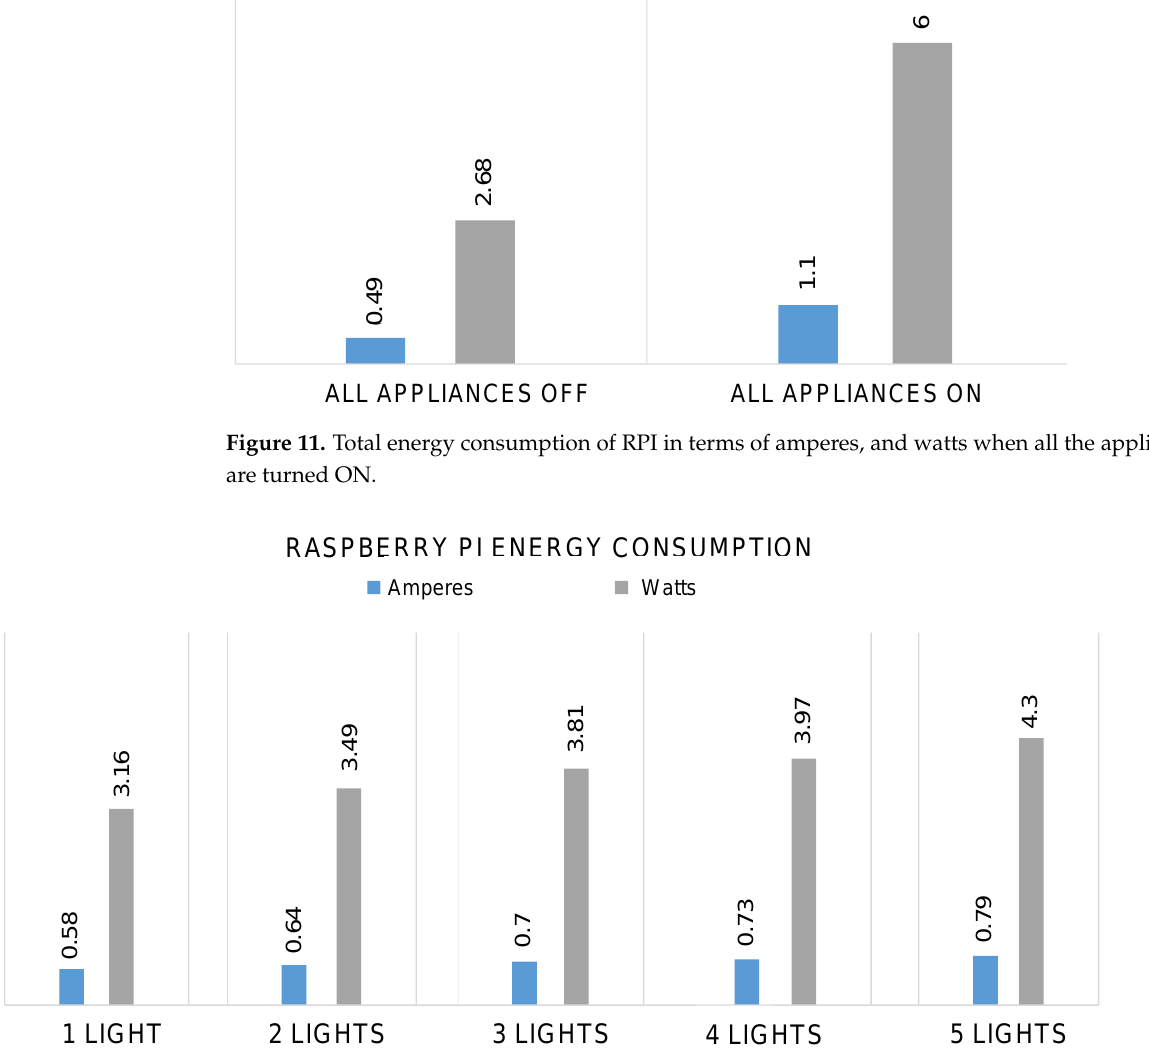
Figure 12. Energy consumption of RPI in terms of amperes, and watts to turn lights ON. Figure 13 shows the energy consumption of the system to turn fans ON, and we can see that a single fan is consuming marginally higher energy as compared to a single light. Similarly, when we increase the number of appliances, then the system consumes a little bit more